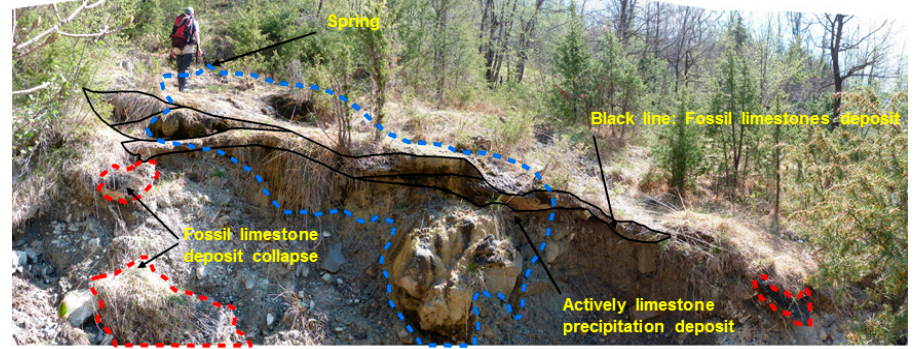
Figure 12. Example of limestone-precipitating springs (LPS) distributed along slopes to forming limestone clusters above the rivulets and streams of nearby springs. Table 1. Areas with eroded vegetation along the Trebbia, Nure and Aveto Rivers (data source: [32]). Streams Eroded Vegetation Areas (Hectares) % with Vegetation Older Than 20 Years (Hectares) 84